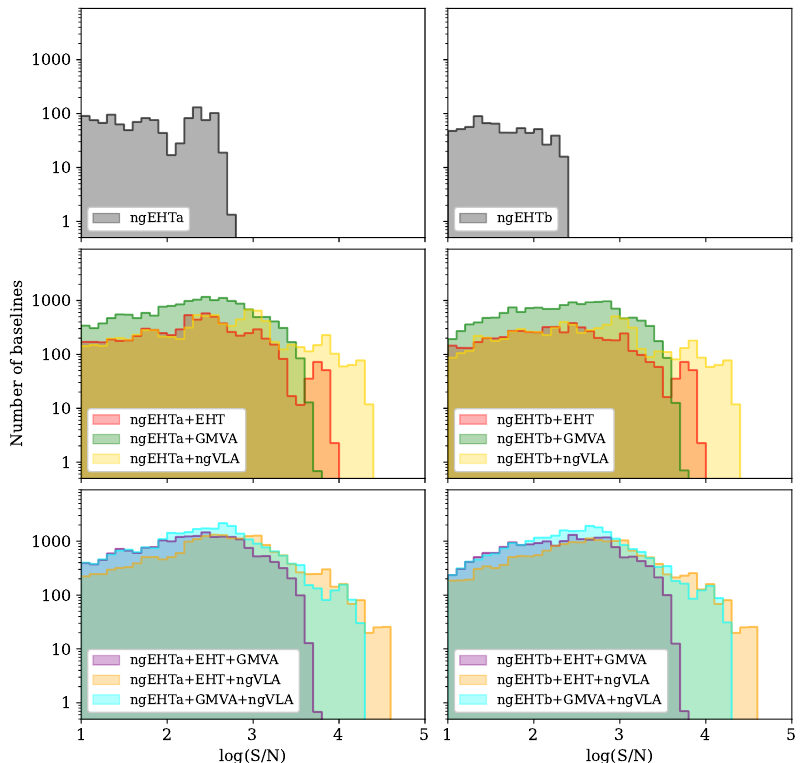
Figure 8. Histograms of baseline signal-to-noise ratios for the different arrays observing M87 at 86GHz. Each histogram is the result of averaging over 100 Monte Carlo realizations of weather at every site, so the resulting histogram bins do not necessarily contain integer numbers of